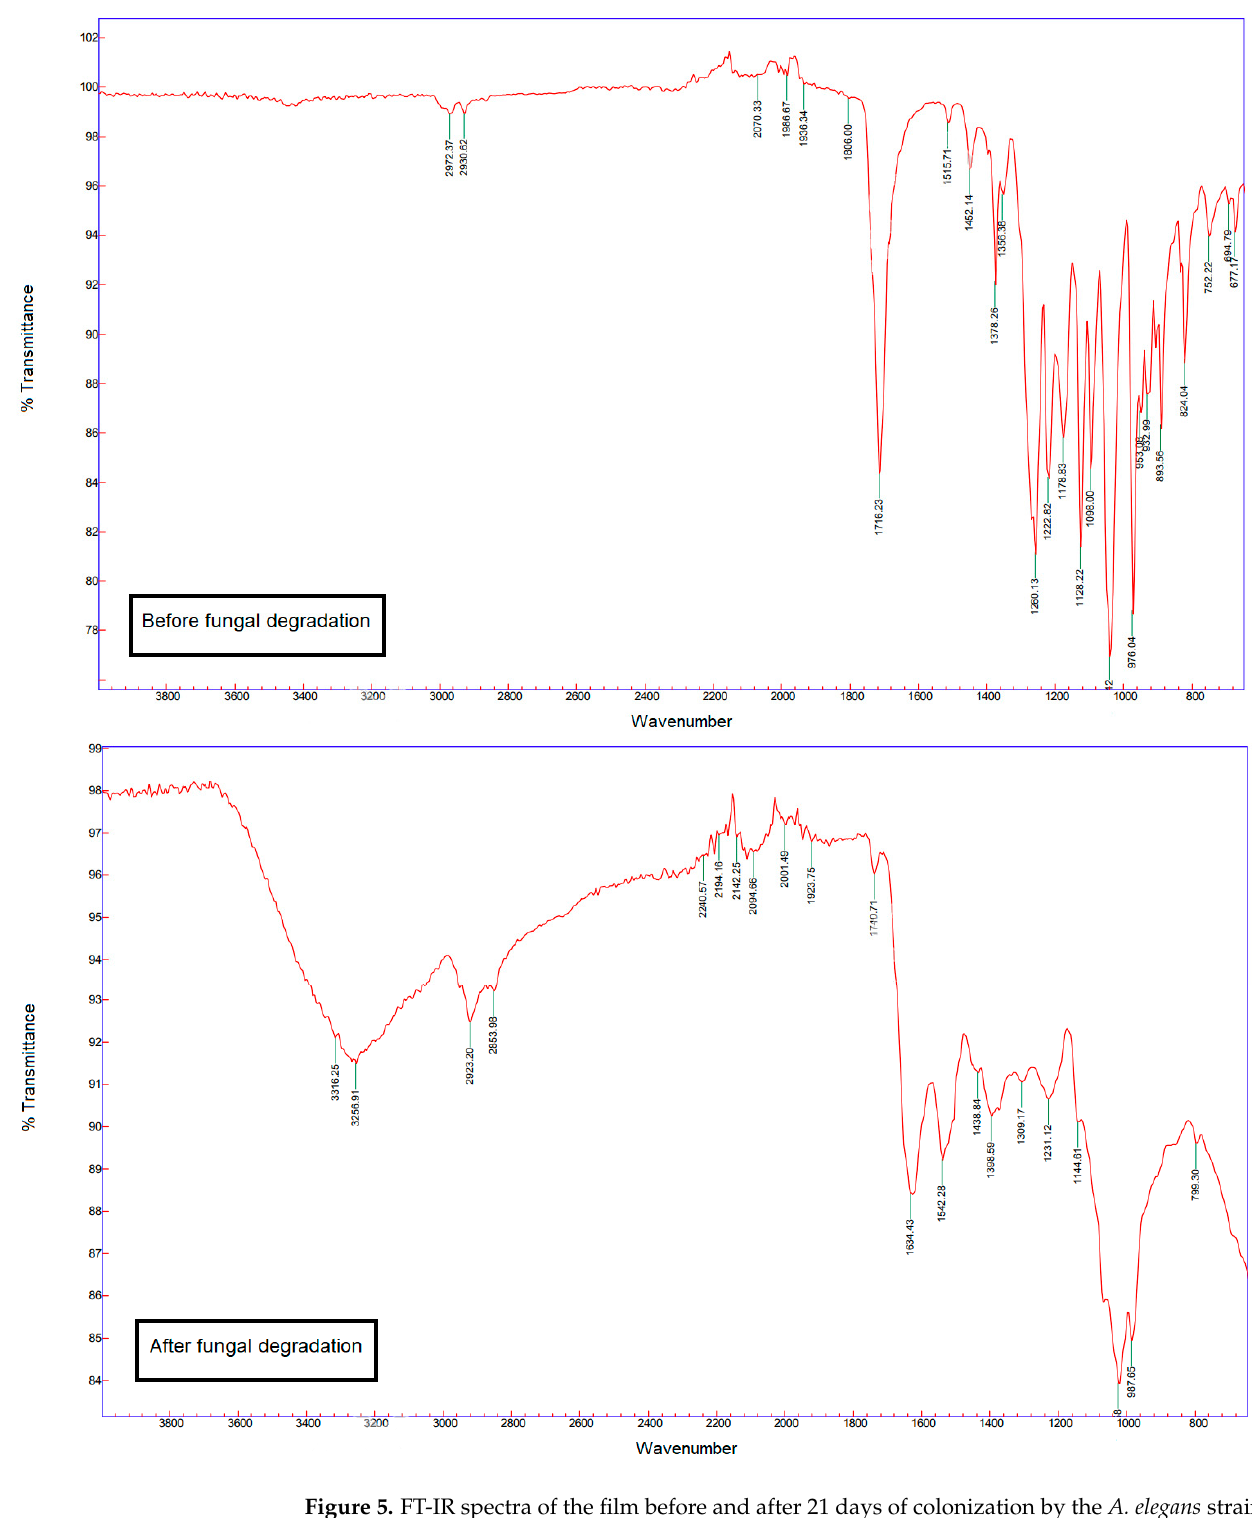
Figure 5. FT-IR spectra of the film before and after 21 days of colonization by the A. elegans strain. After having selected the strain and confirmed its potential in the degradation of PHB, the effect of BDF composition in the blends was investigated using imagery analysis of the pictures that were taken during the fungal growth. Indeed, in the media containing